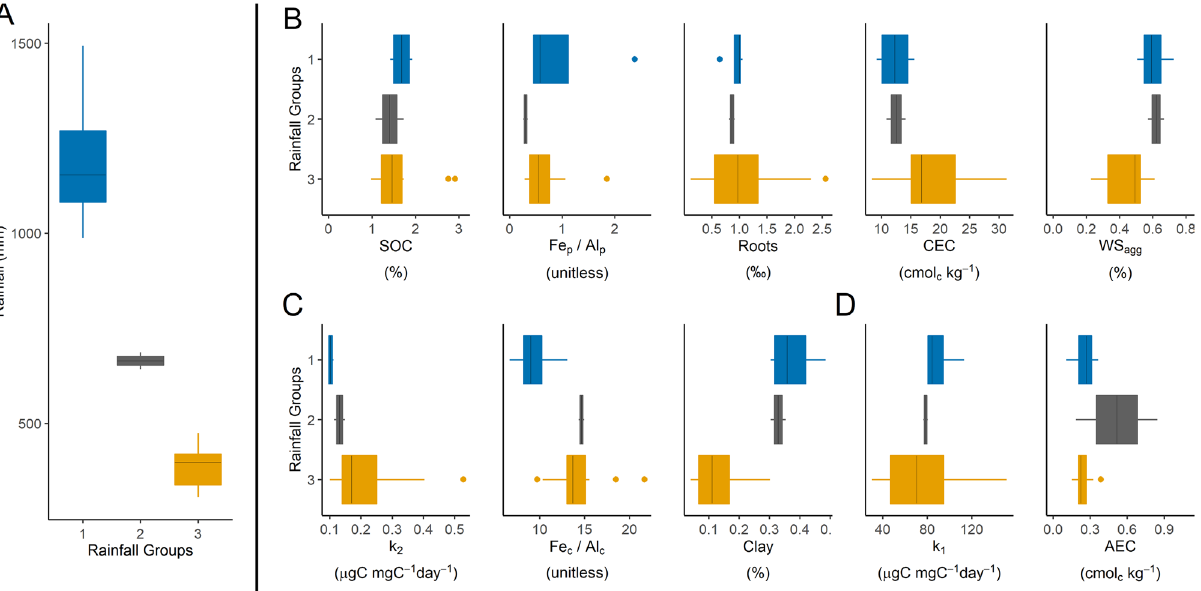
Figure 6. Hierarchical clustering of surface C response, physicochemical predictors, and rainfall. Median values, first and third quantiles, and 95% confidence intervals are shown for each hierarchical depth group ( A ), SOC and best physicochemical predictors ( B ), k 2 alongside best predictors ( C ), and k 1 and best predictors ( D